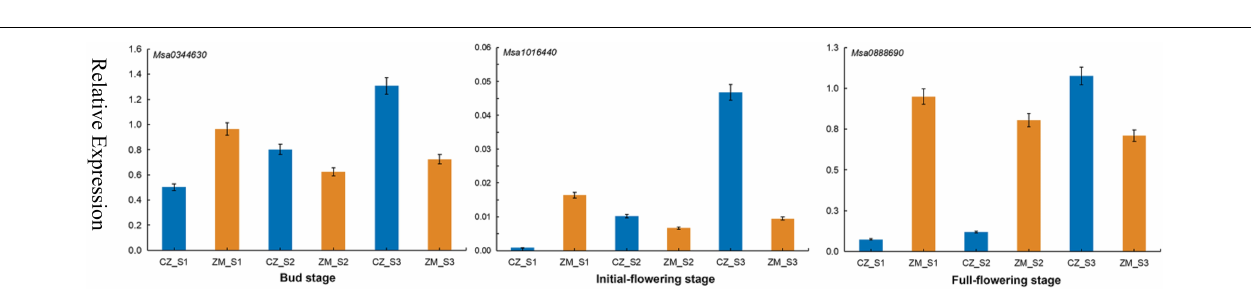
FIGURE 6 | qRT–PCR analysis of three candidate genes in three stages associated with the flowering time in